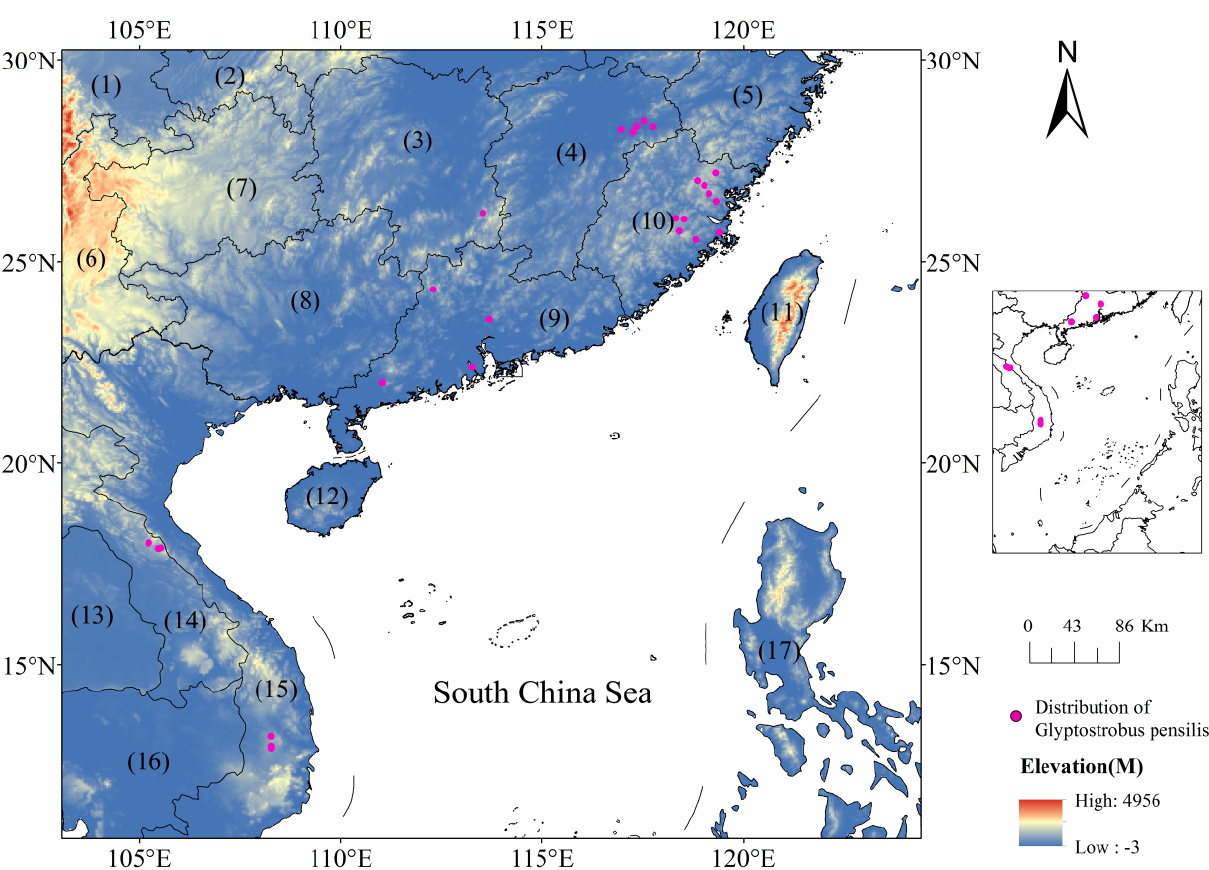
Figure 2. Distribution of occurrence records of G. pensilis. (1) Sichuan; (2) Chongqing; (3) Hunan; (4) Jiangxi; (5) Zhejiang; (6) Yunnan; (7) Guizhou; (8) Guangxi; (9) Guangdong; (10) Fujian; (11) Taiwan; (12) Hainan; (13) Thailand; (14) Laos; (15) Vietnam; (16) Cambodia; (17) Philippines. Consecutive numbers (1)–(12) are the provinces of China.